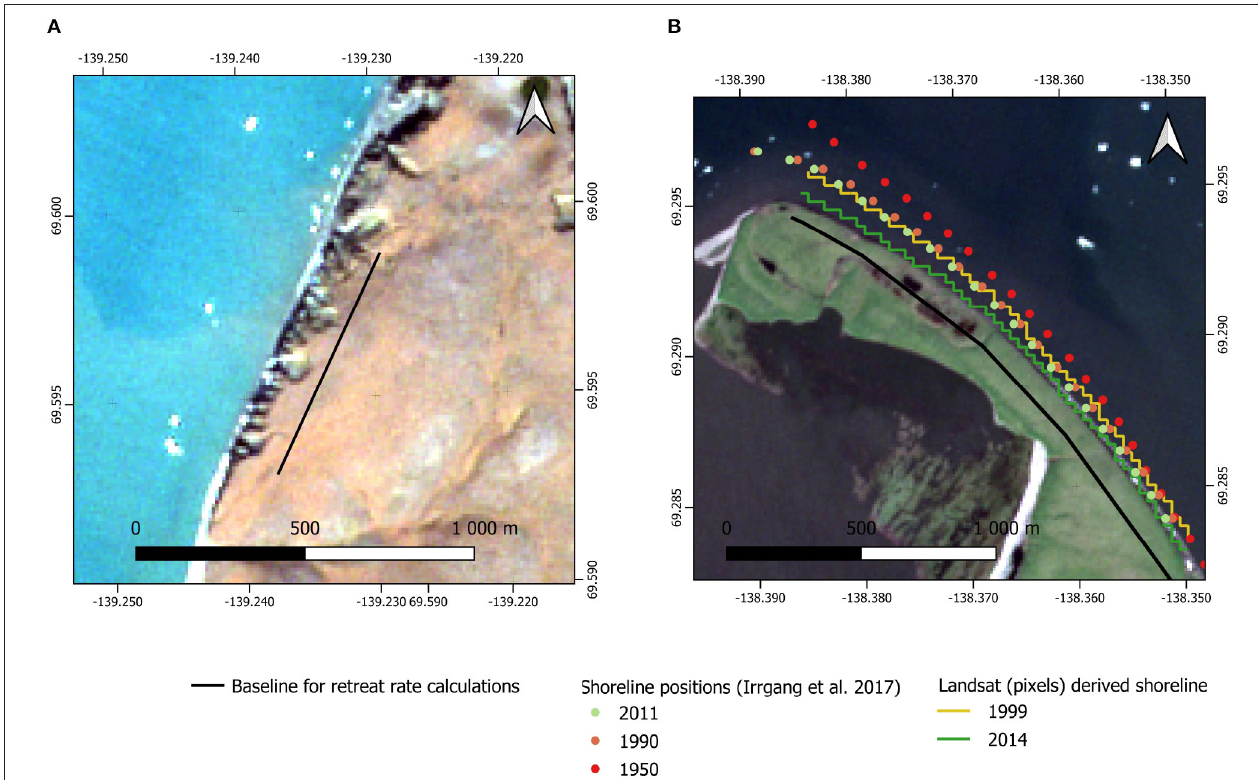
FIGURE 2 | Study sites along the Beaufort Sea Coast, Canada: (A) Avadlek on Herschel Island, (B) Kay Point, including shoreline points for rate calculations from Irrgang et al. (2017) and Landsat trend data based on probability of land to water change between 1999 and 2014 (Nitze et al., 2018) (visualization based on vectorized 30 × 30 m pixels). The baseline for rate calculations in this paper is shown in addition. Background: RGB (band 4, 3, and 2) composite of Sentinel-2 (optical, multi-spectral), Sep 20